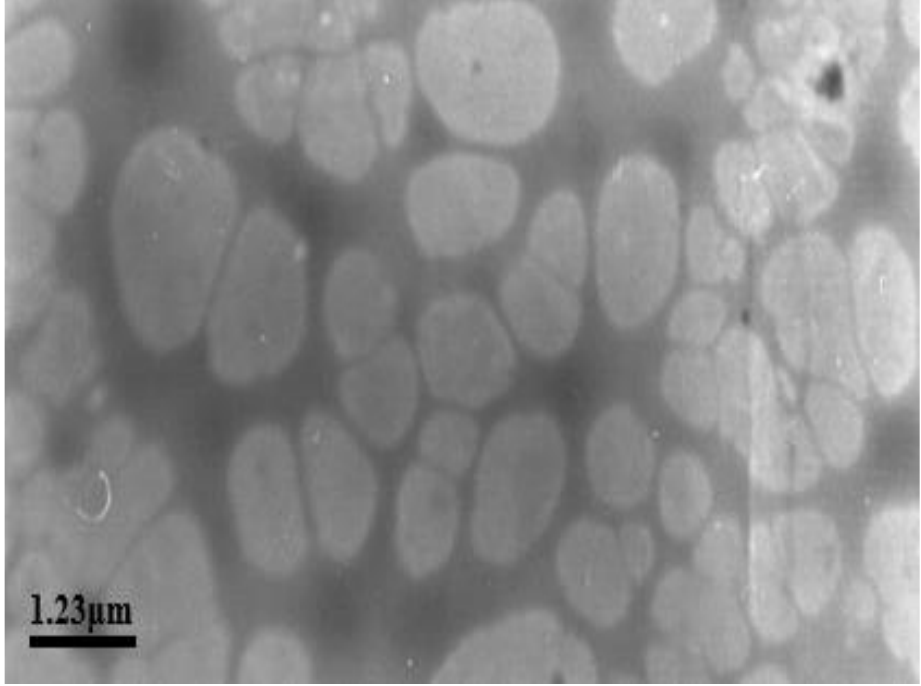
Figure 9. Micro-structure of the drag reducer not subjected to flow shear.